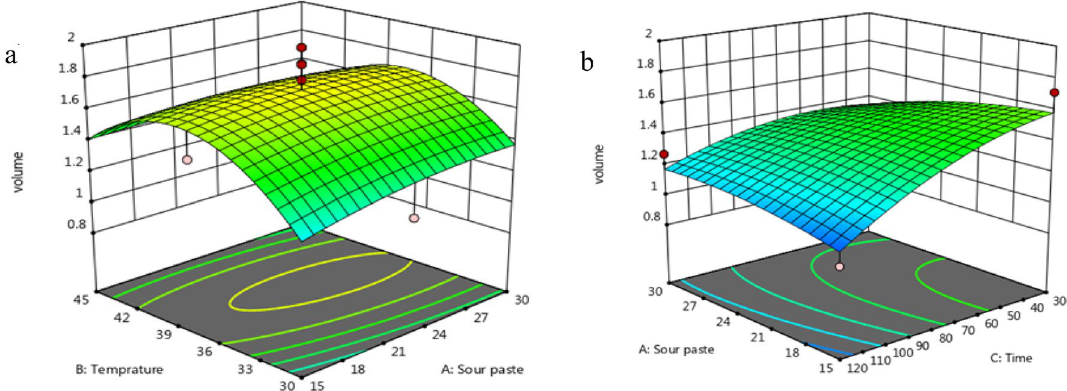
Fig. 3 Effect of temperature and sourdough amount a and fermentation time and sourdough amount b on volume of Barbari bread proper- ties